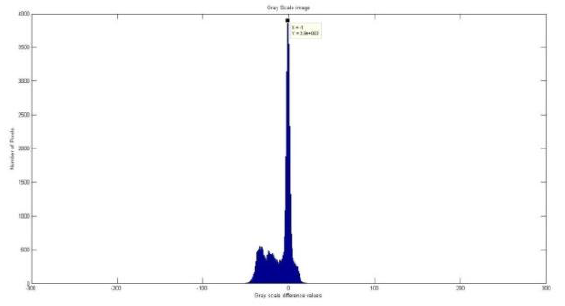
Figure 8. Histogram of images difference of test 2